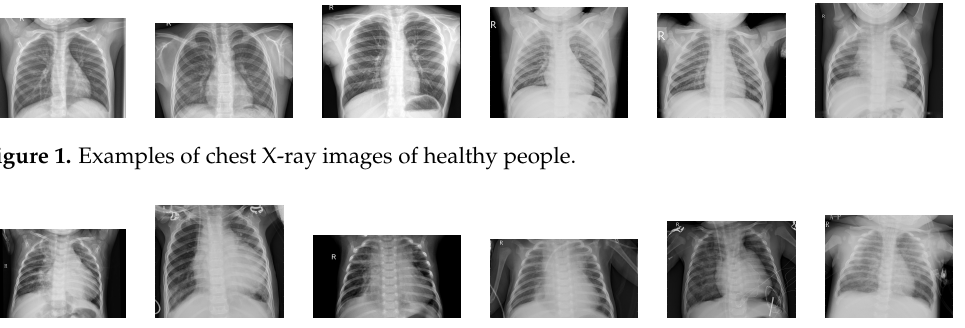
Figure 2. Examples of chest X-ray images of people with pneumonia presenting a bandlike opaqueness with a peripheral, mid-to-lower lung zone distribution—white infiltrates, a hallmark of